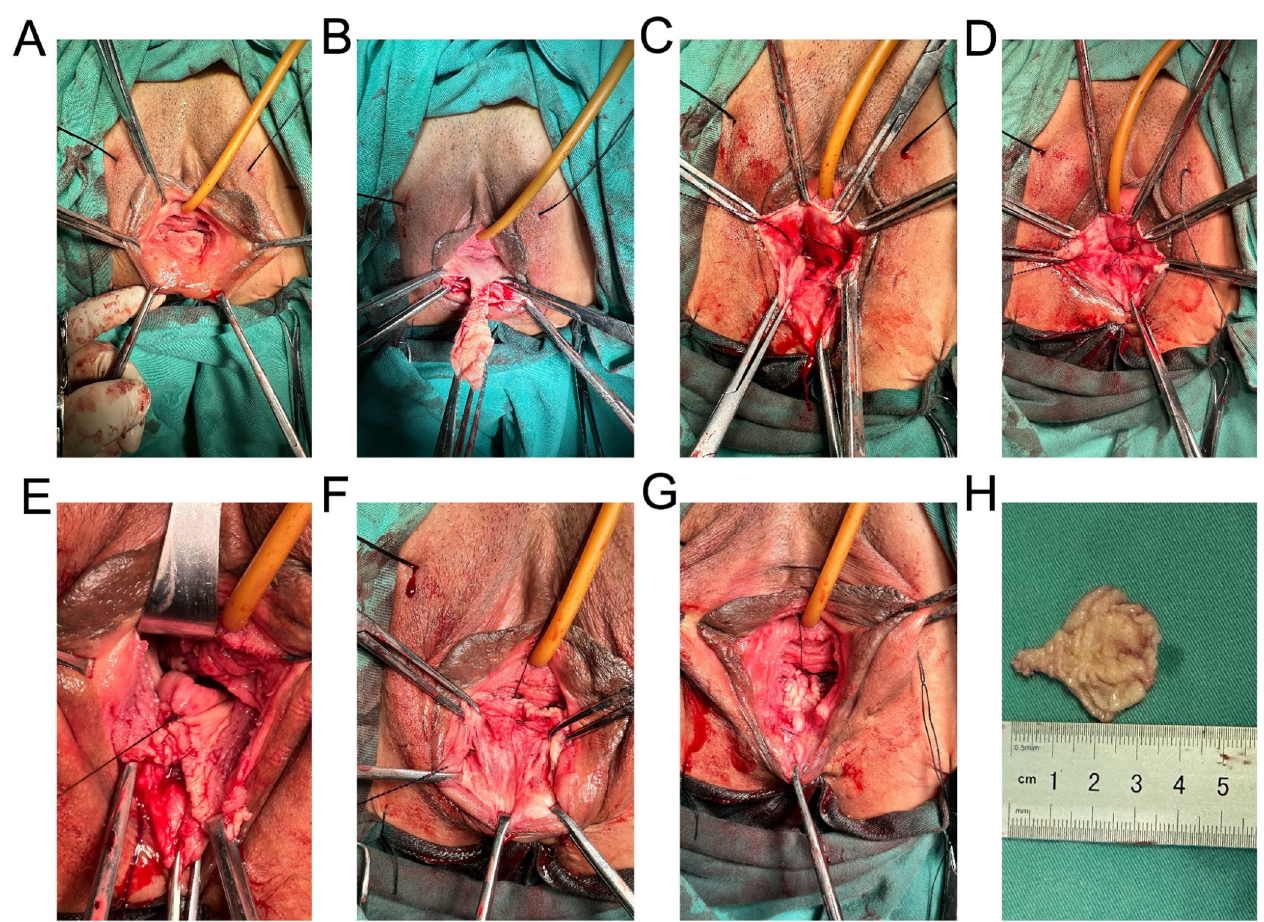
Figure 1. Methods of posterior pelvic floor reconstruction. ( A ) Injection of posterior wall water pad into the space under the pelvic septum. ( B ) Design of vaginal flap. ( C ) Suture the fascia beside rectum and vagina. ( D ) Narrow vaginal genital hiatus. ( E ) Suture the posterior vagina. ( F , G ) Suture the external anal sphincter and reconstruct the perineum. ( H ) Vaginal flap.